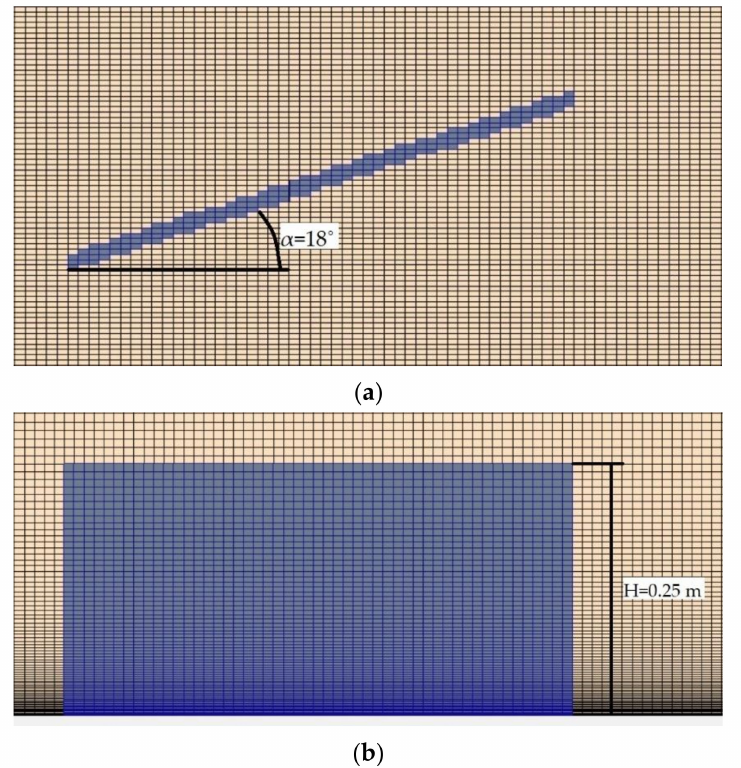
Figure 5. Cell-set construction of the VG with the cell-set model for α = 18 ◦ and H = 1 δ . ( a ) Top view and ( b ) side view.